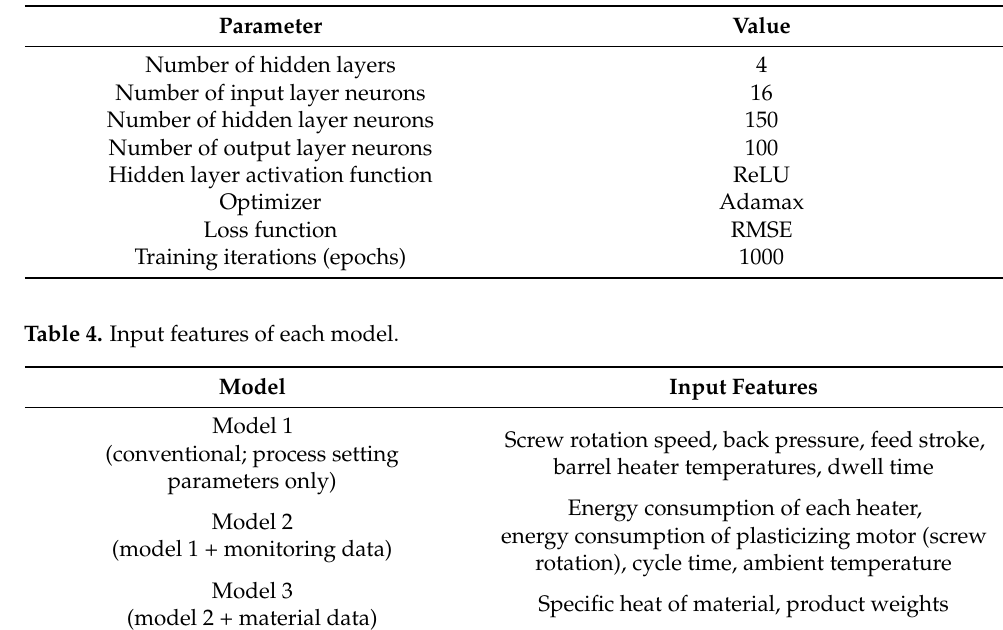
Figure 7. Multilayer neural network model structure used in the experiment. Table 3. Machine learning model architecture.